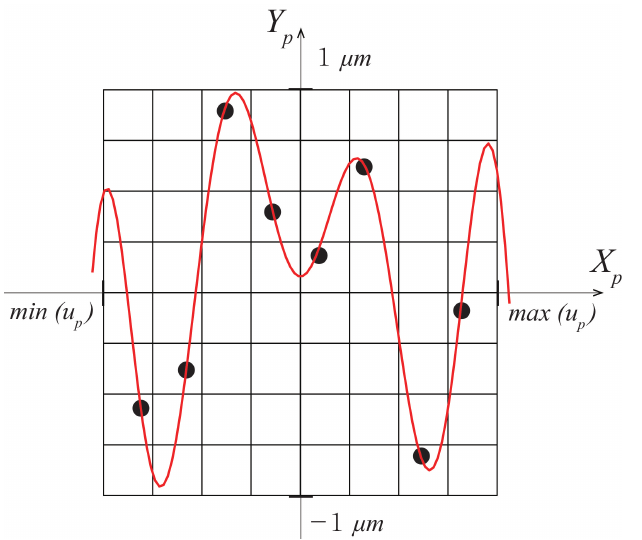
Figure 9. Latin hypercube sampling (LHS) method for the case of machining tool uncertainties: (cid:101) = 1. By interpolating these points, we obtain a rack cutter profile sample; see Section 3.1 and Figure